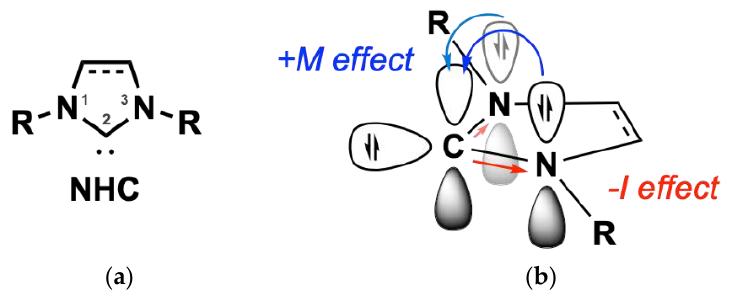
Figure 3. ( a ) Electronic stabilization of NHC of the free carbene electrons in C2 position ( b ) via σ -withdrawing and π -donating effects of the nitrogen heteroatoms. Reprinted with permission from Ref. [39] . Copyright (2021) Wiley-CVH.